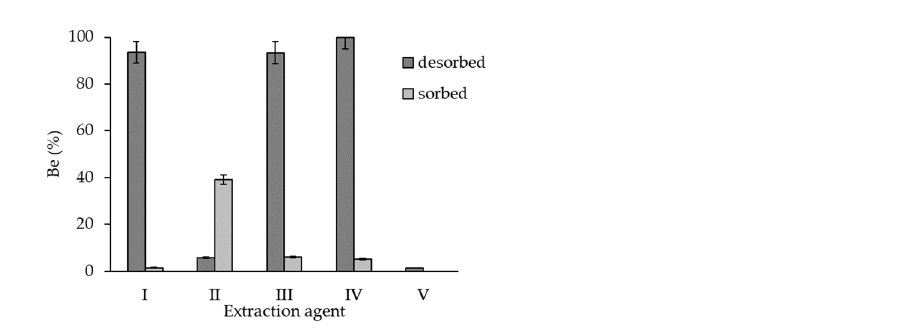
Figure 9. The efficiency of Be(II) desorbed from MWBI by extraction agent: I—0.01 M H 2 SO 4 , II— Na 2 CO 3 , III—CaCO 3 with added HCl, IV—0.01 M HCl solution, V—deionized water; and efficiency of subsequent sorption of 1 mg/L Be(II).